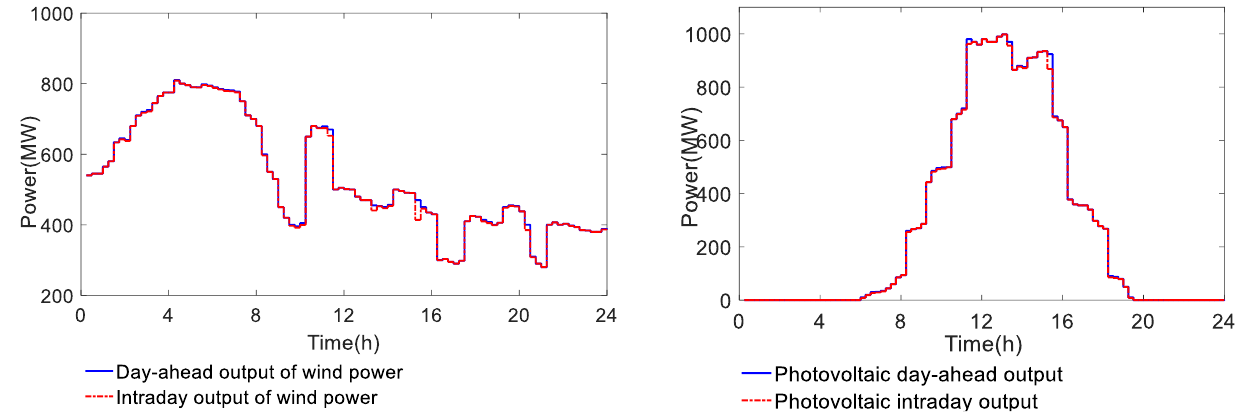
Figure 8. Comparison of day-ahead plan and actual output of wind farm group and photovoltaic power station group.